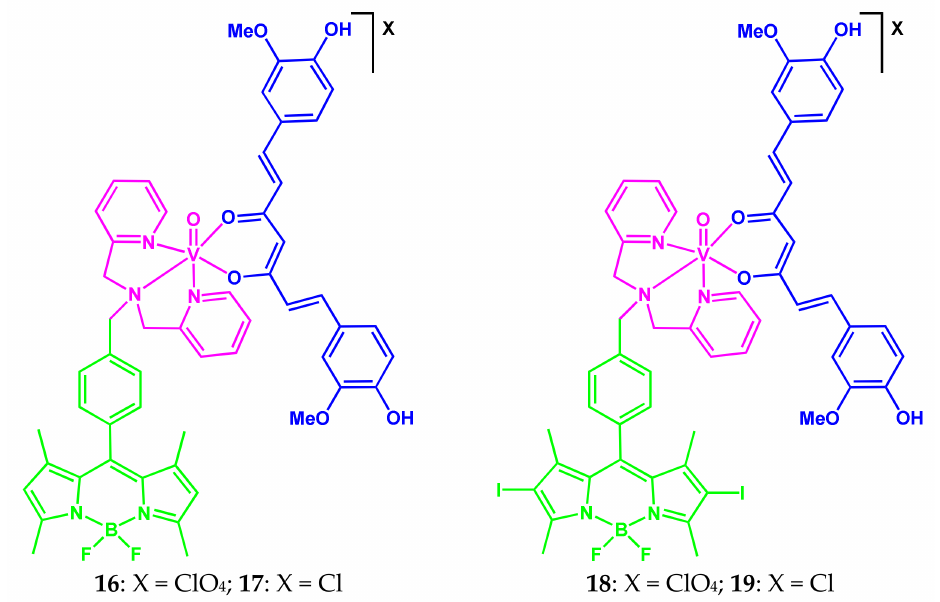
Scheme 10. Structures of compounds 16 – 19 .